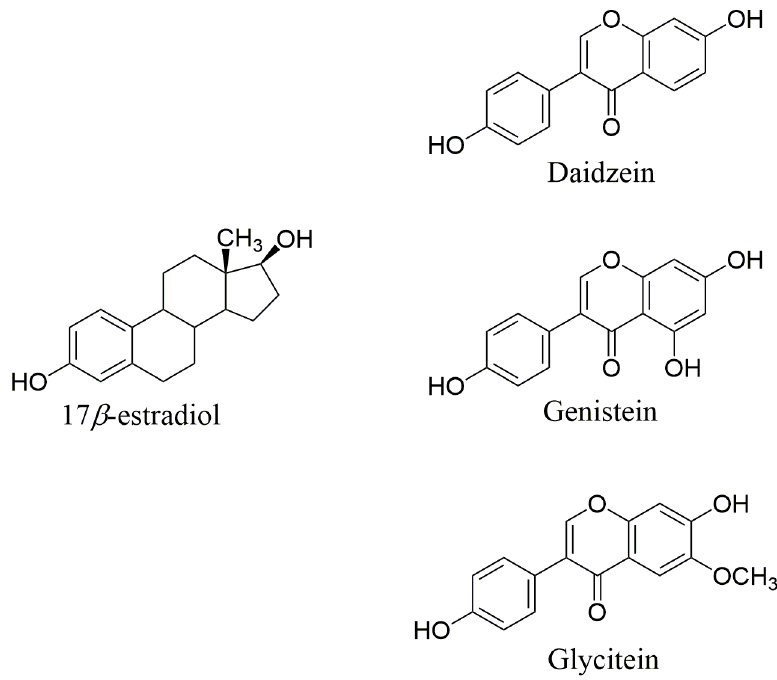
Figure 2. Main isoflavones and their structural similarity to 17 β -estradiol.